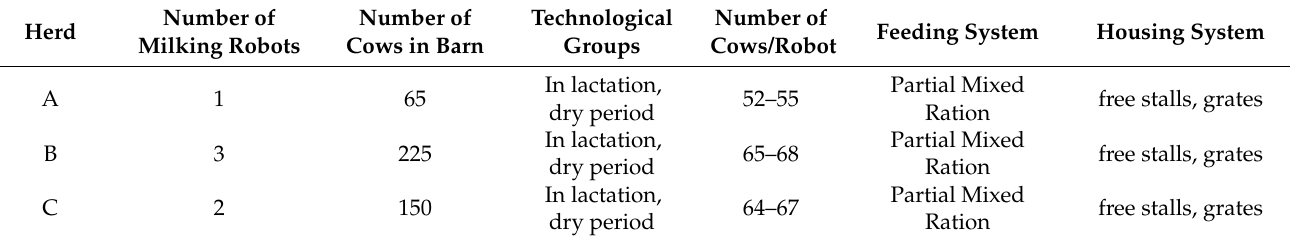
Table 1. General characteristics of the studied